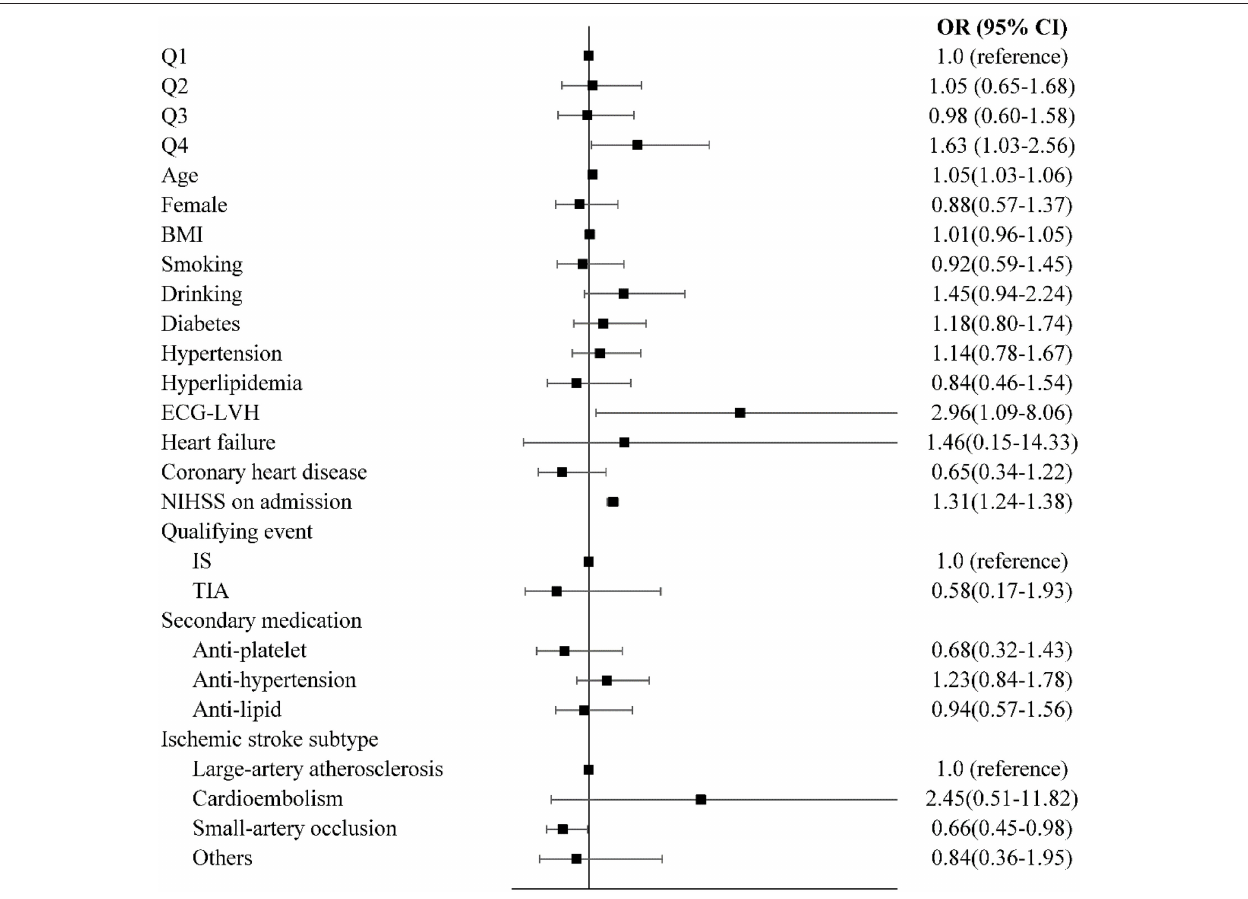
FIGURE 3 | Multivariable logistic regression analyses between QTd and functional recovery. OR, odds ratio; CI, confidence interval; mRS, modified Rankin Scale.